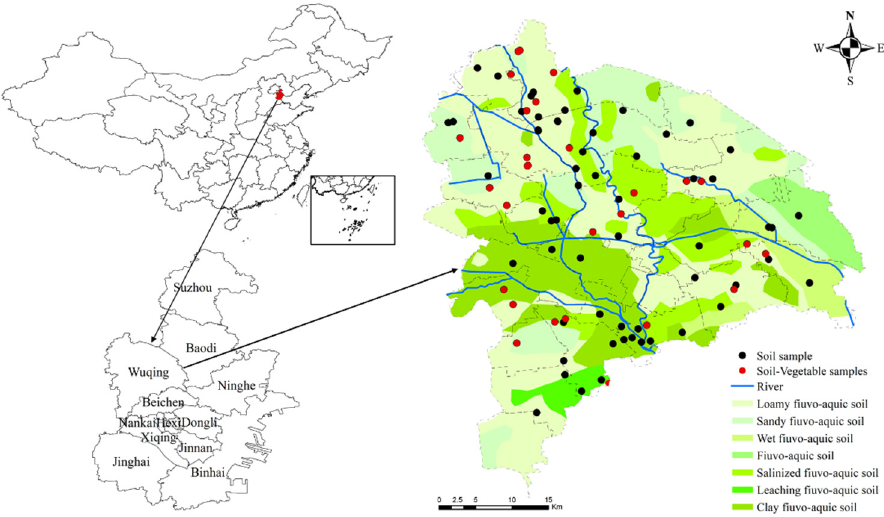
Figure 1. Location of the study area and the sampling point distribution.